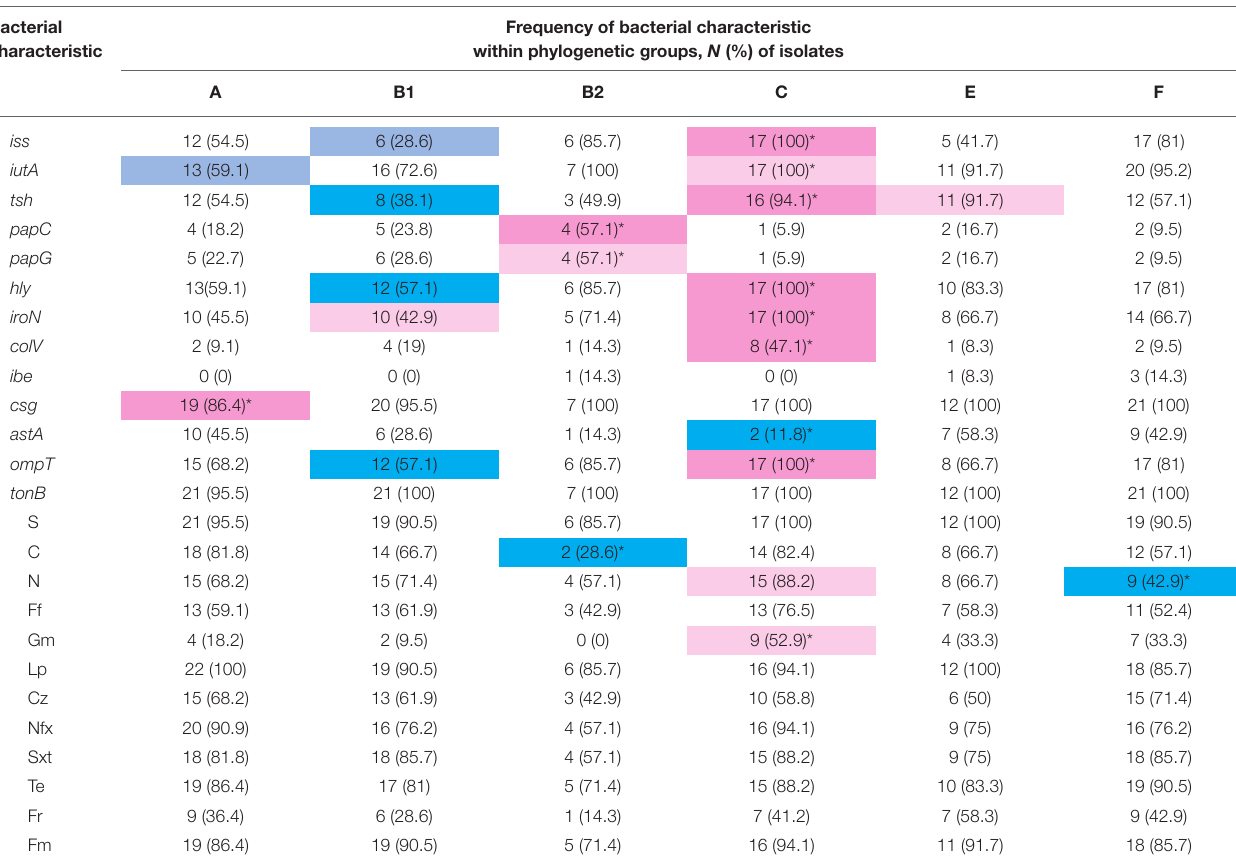
TABLE 5 | Distribution of virulence-associated genes (VAG) and resistance to antimicrobial agents within phylogenetic groups. Bacterial characteristic